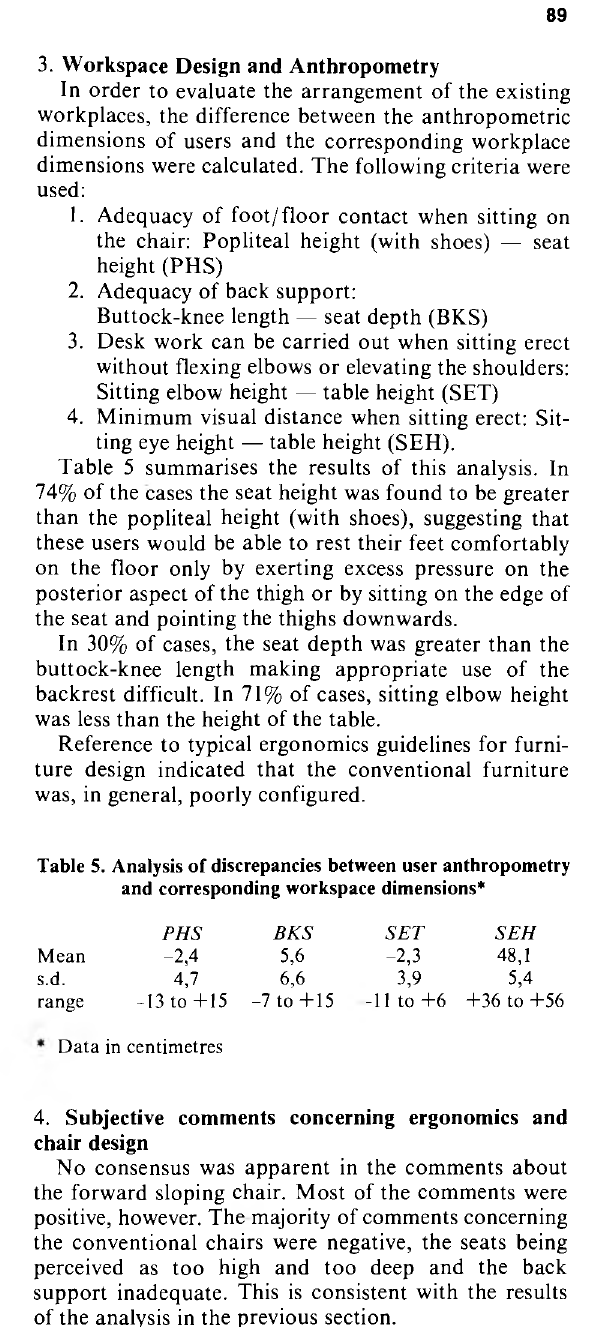
Forward Sloping Usual Chair